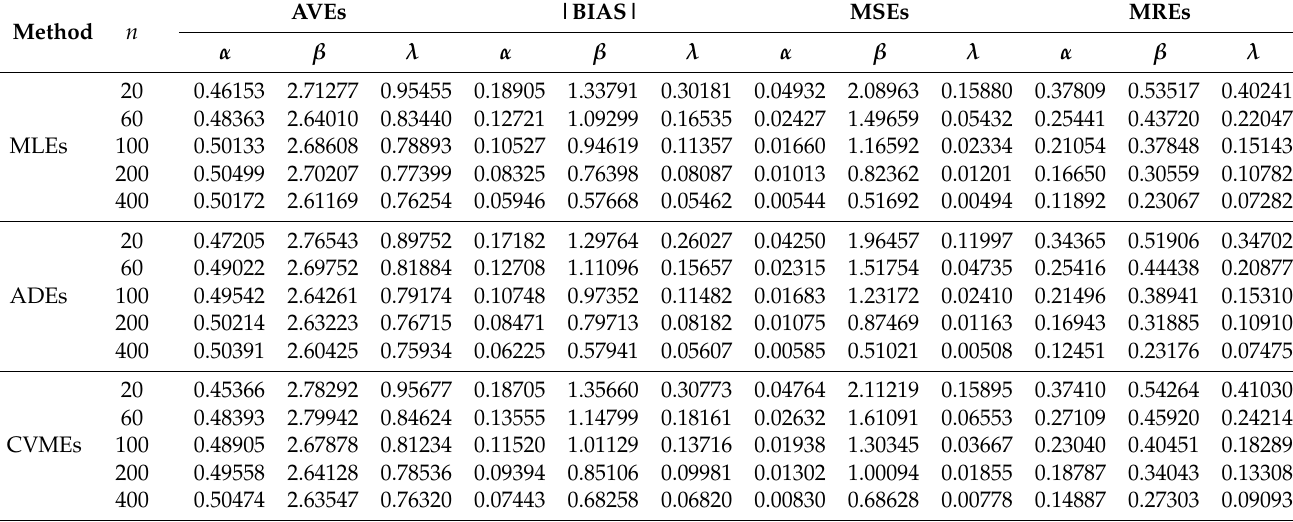
Table 8. Numerical values of the Ex-LL distribution for the parameters α = 0.5, β = 2.5, λ =